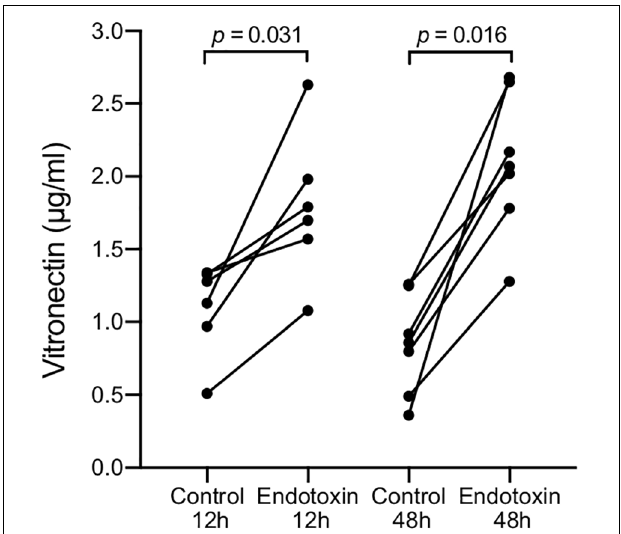
FIGURE 2 | Endotoxin instillation increased extracellular vitronectin concentrations in BALF. Healthy volunteers ( n = 13) were bronchially exposed to endotoxin in one lung and to PBS in the contralateral lung segment. BALF samples were collected from both exposure sites 12 h ( n = 6) or 48 h ( n = 7) after endotoxin challenge. Values from the same individual are connected with a line. Vitronectin concentrations were determined by ELISA, and p -values were calculated using the Wilcoxon matched-pairs signed rank